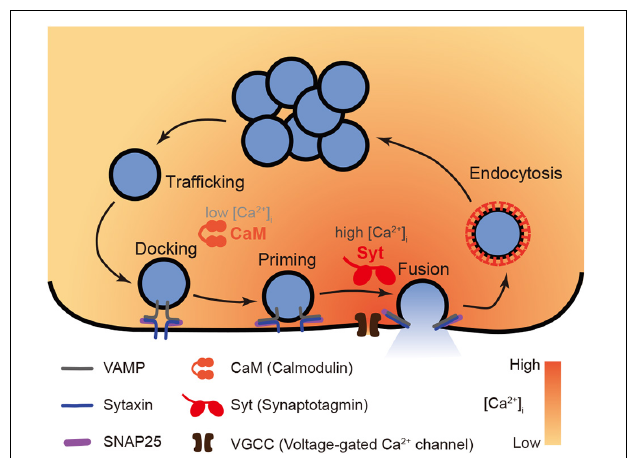
FIGURE 1 | A model of functions of Ca 2 + sensor CaM vs. Syt in exocytosis. The whole process of Ca 2 + dependent exocytosis includes vesicle trafficking, docking, priming, and fusion. The final membrane fusion is trigger by Ca 2 + influx through VGCC that induces a boost of [Ca 2 + ] i up to micromolar level. The low affinity Ca 2 + sensor Syt (specifically Syt1 or Syt2) is suitable to convey such high Ca 2 + signals to vesicle fusion events. Meanwhile, in early steps prior to fusion, the high affinity Ca 2 + sensor CaM plays a role to facilitate vesicle trafficking, docking, and priming in submicromolar [Ca 2 + ] i